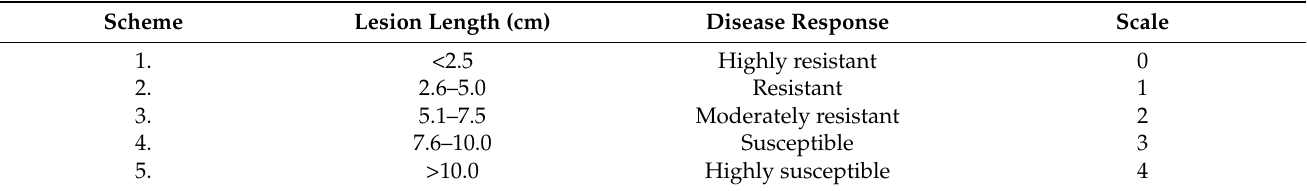
Table 2. Scale used for screening different populations against S. sclerotiorum as suggested by Garg et al. [20]. Scheme Lesion Length (cm) Disease Response